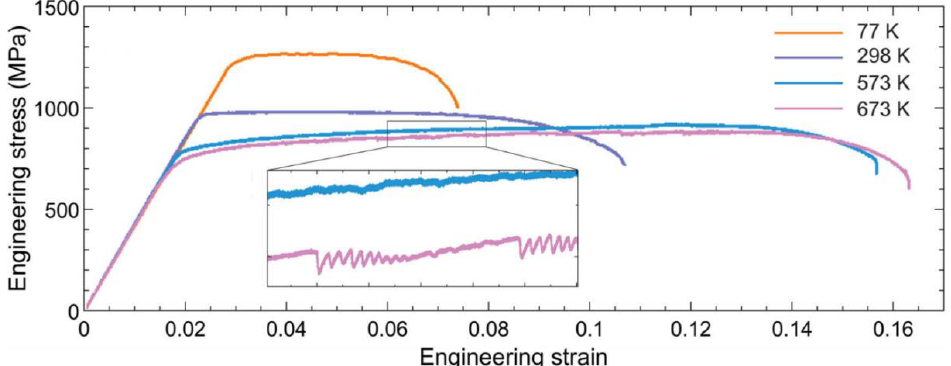
Figure 47. The engineering stress vs. engineering strain for the BCC HfNbTaTiZr HEA that was tested at temperatures ranging from 77 to 673 K, at a strain rate of 1 × 10 − 4 s − 1 (reproduced from Reference [301] with permission).